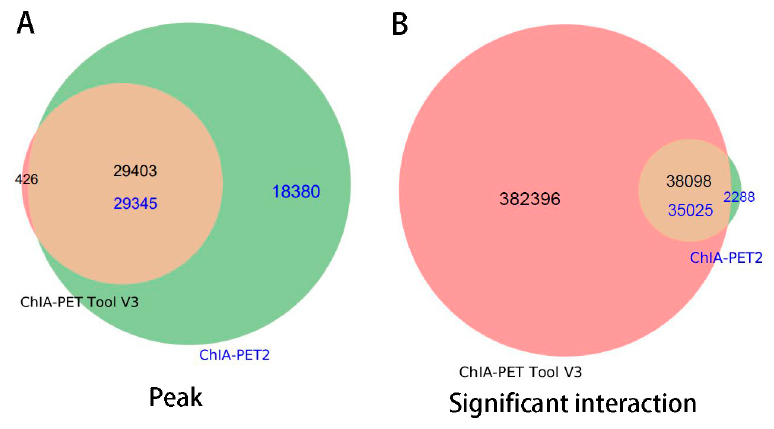
Figure 18. Overlap of peaks and interactions detected by different tools from human GM12878 cells. Significant interactions require at least three supportive PETs and FDR of less than 0.05.